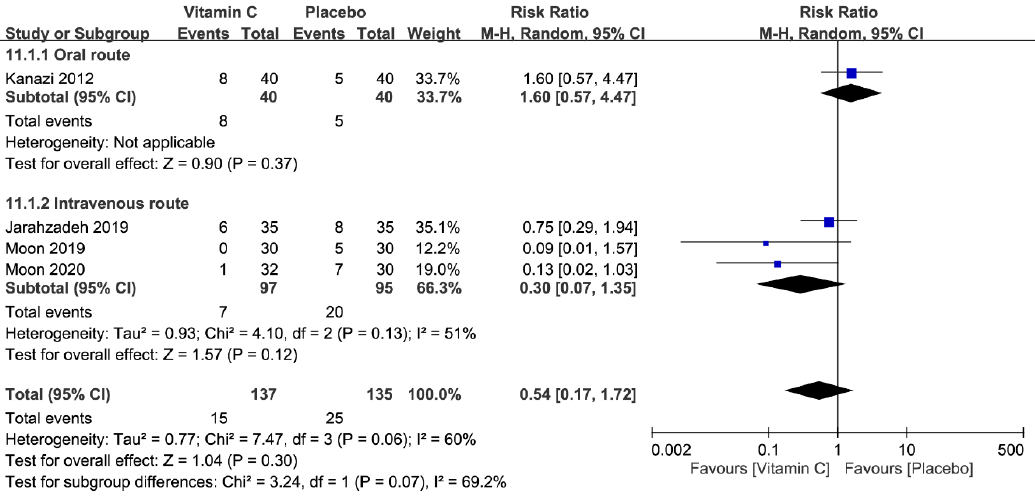
Figure 13. Forest plot for the comparison of the incidences of postoperative nausea or vomiting 24 h after surgery between vitamin and placebo groups. CI, confidence interval; RR, risk ratio; M-H = Mantel–Haenszel.